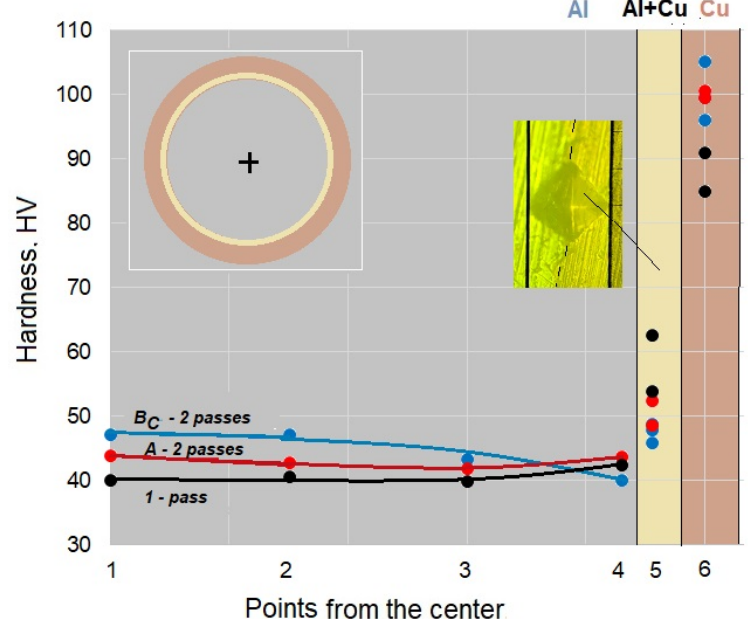
Figure 5. Hardness after deformation versus distance from the centre measured at six points in the aluminium part (points 1–4), at the interface (point 5) and in the copper cladding (point 6). (The two similarly coloured points at the interface and at the copper cladding represent measurements for thick and thin sheaths).